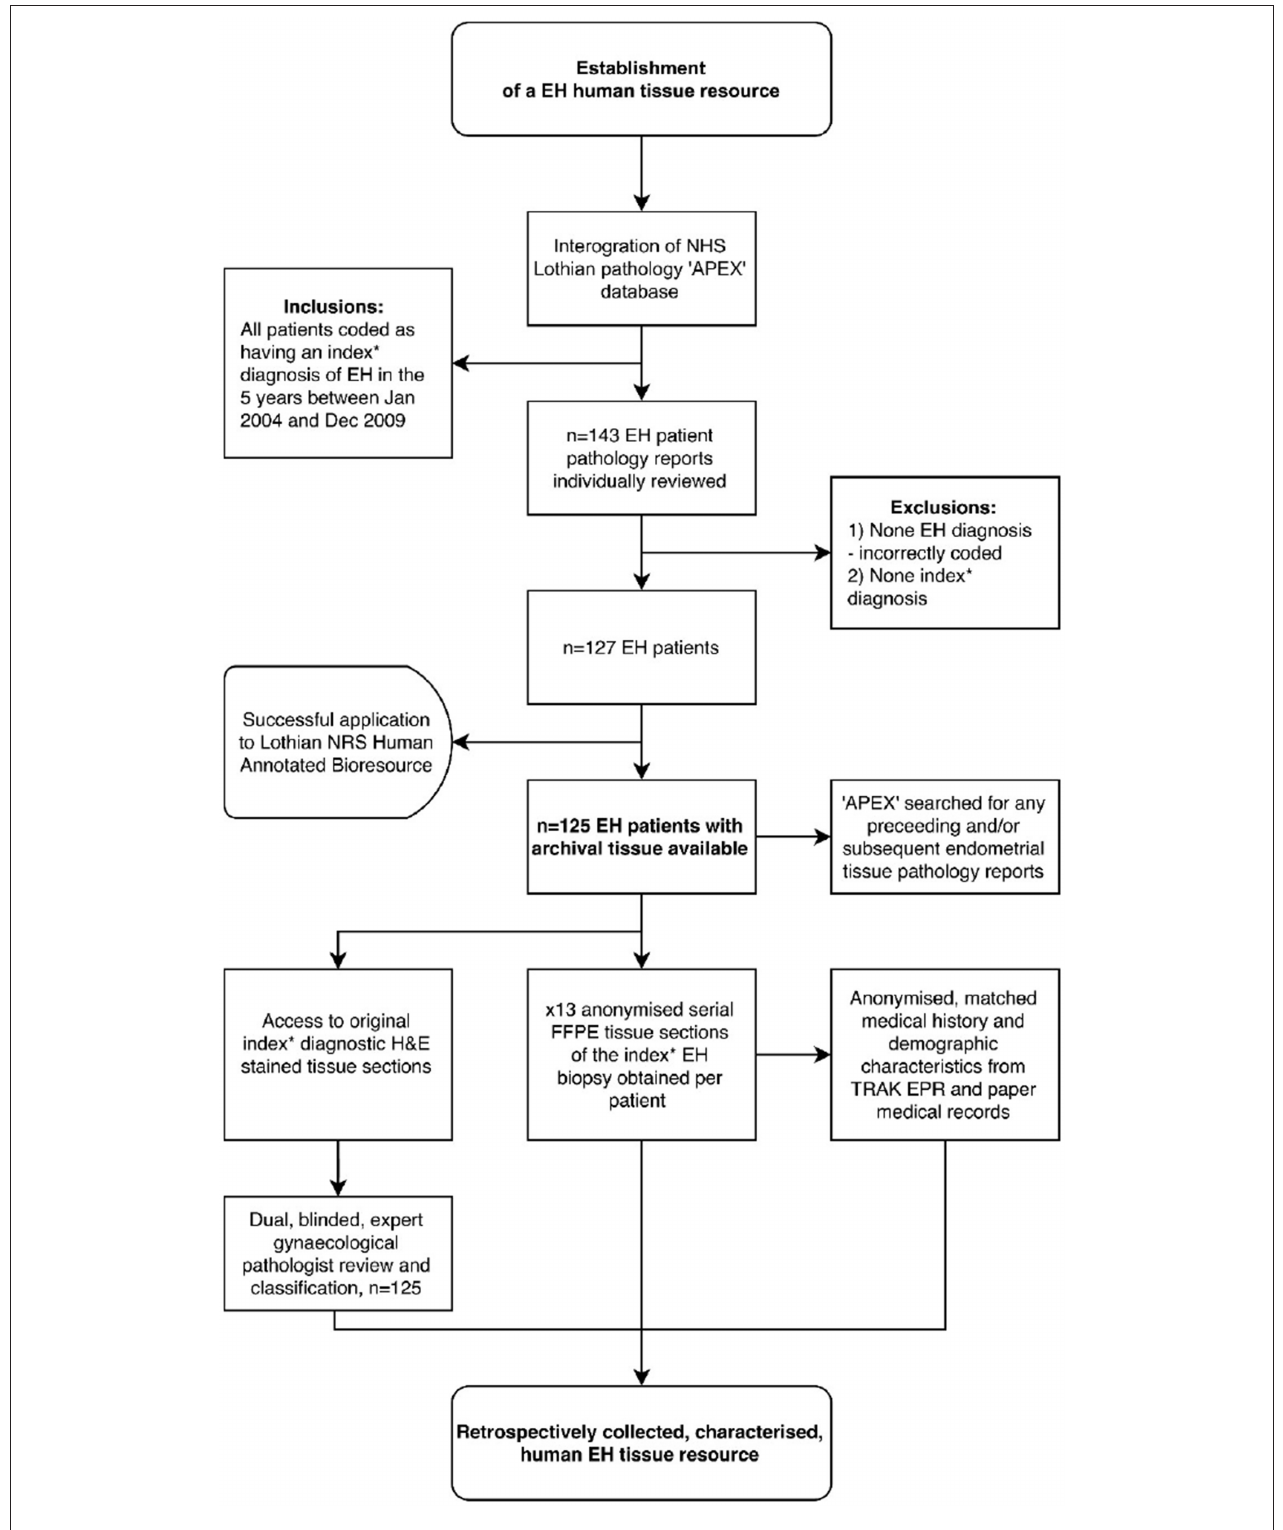
FIGURE 1 | Summary: Workflow-diagram for the establishment of a human endometrial hyperplasia (EH) tissue resource. *Index refers to the first documented EH biopsy, i.e., not a repeat or follow-up biopsy. TRAK EPR, NHS Lothian’s electronic patient records system; APEX, NHS Lothian’s pathology records system.